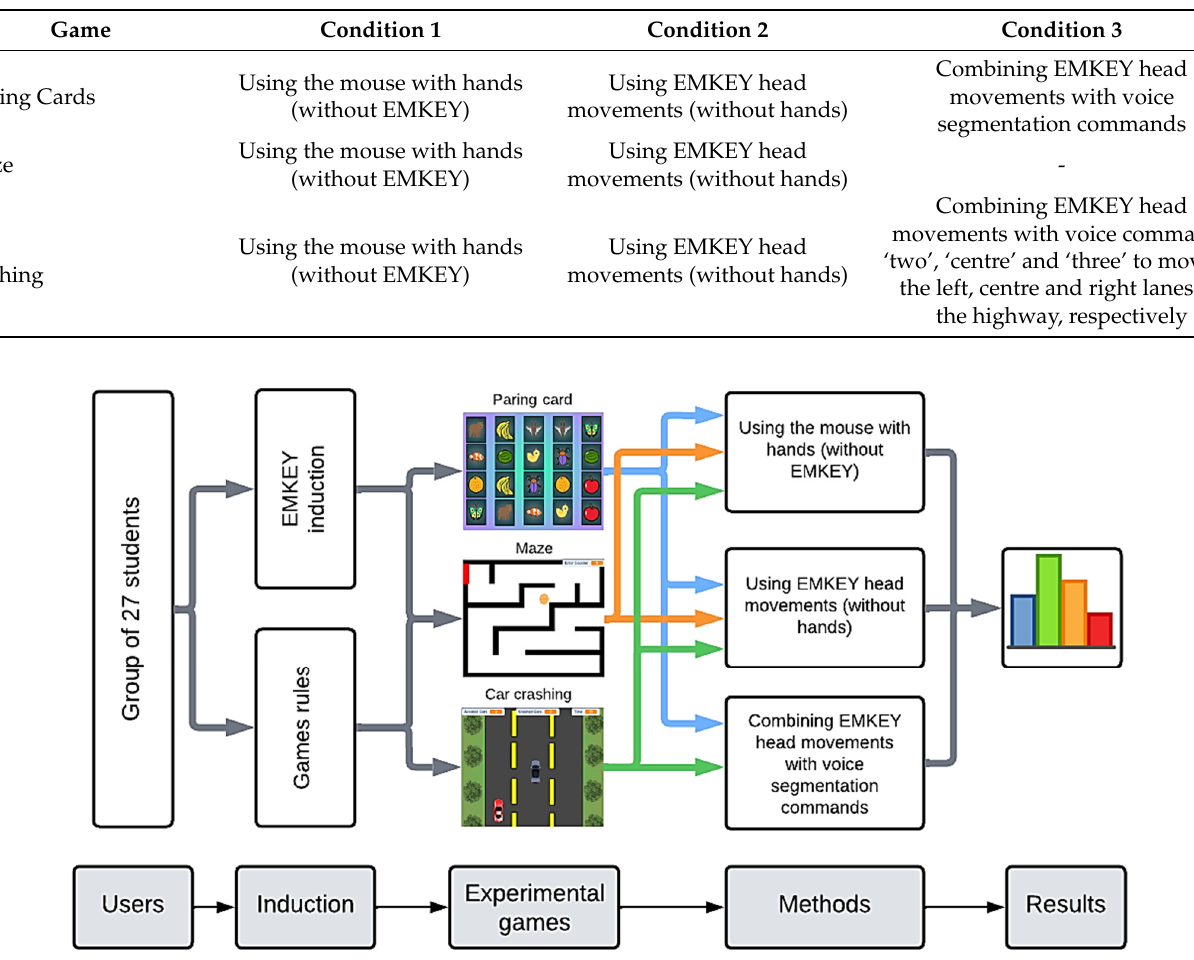
Table 2. Experimental conditions for each game.